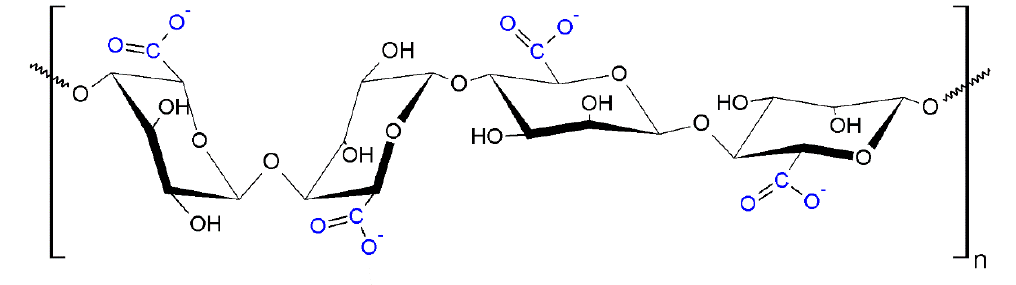
Figure 22. Structure of alginic acid pristine bionanomolecules.